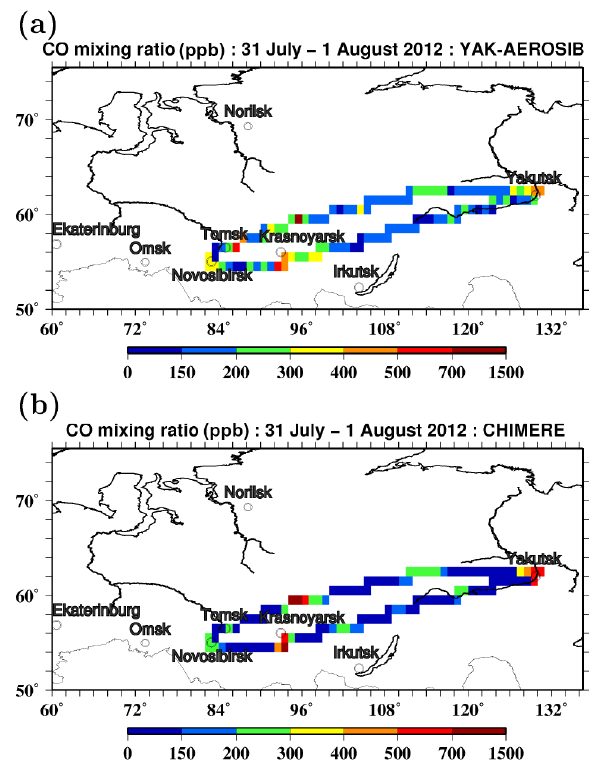
Figure 8. Time series of the EC and OC mass concentrations (µgm − 3 ) measured at ZOTTO in comparison to their simulated matchups from the “base-opt”, “base-ini”, and “bgr” simulations. The values of several statistical characteristics are reported in the figure legends; the confidence intervals for the biases are evaluated in terms of the 90th percentile. The EC and OC concentrations from the “bgr” simulation are plotted using the corresponding axes on the right-hand side of the panels.